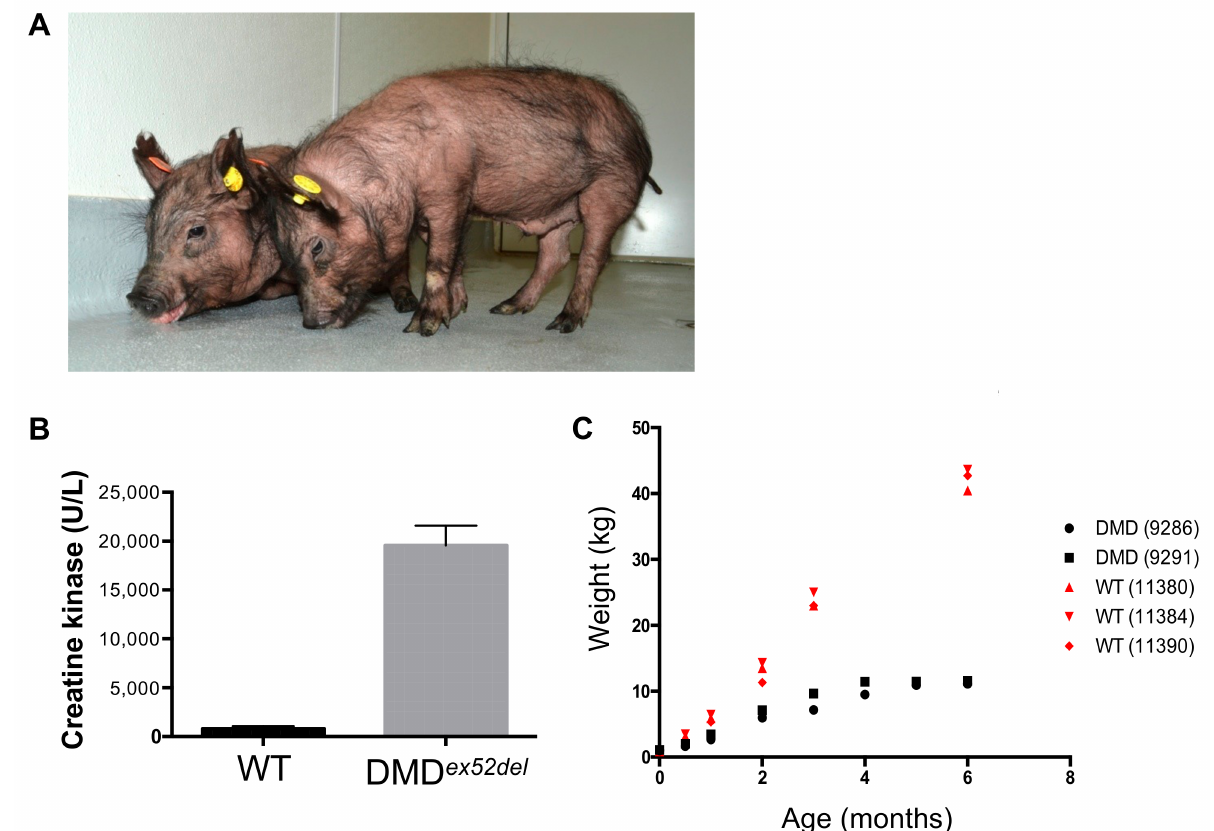
Figure 5. DMD ex52del pigs display dystrophic phenotypes in clinical assessment. ( A ) Physical abnormality in male DMD e x52del pigs at 15 weeks of age (IDs 9286 and 9291) with postural instability and associated forward positioning of the pelvic limbs. ( B ) Serum creatine kinase measurements from wild-type ( n = 3) and DMD pigs ( n = 4) on the day of birth. Error bars indicate SEM. ( C ) The poor growth rate of DMD pigs compared to age-matched wild-type (WT)